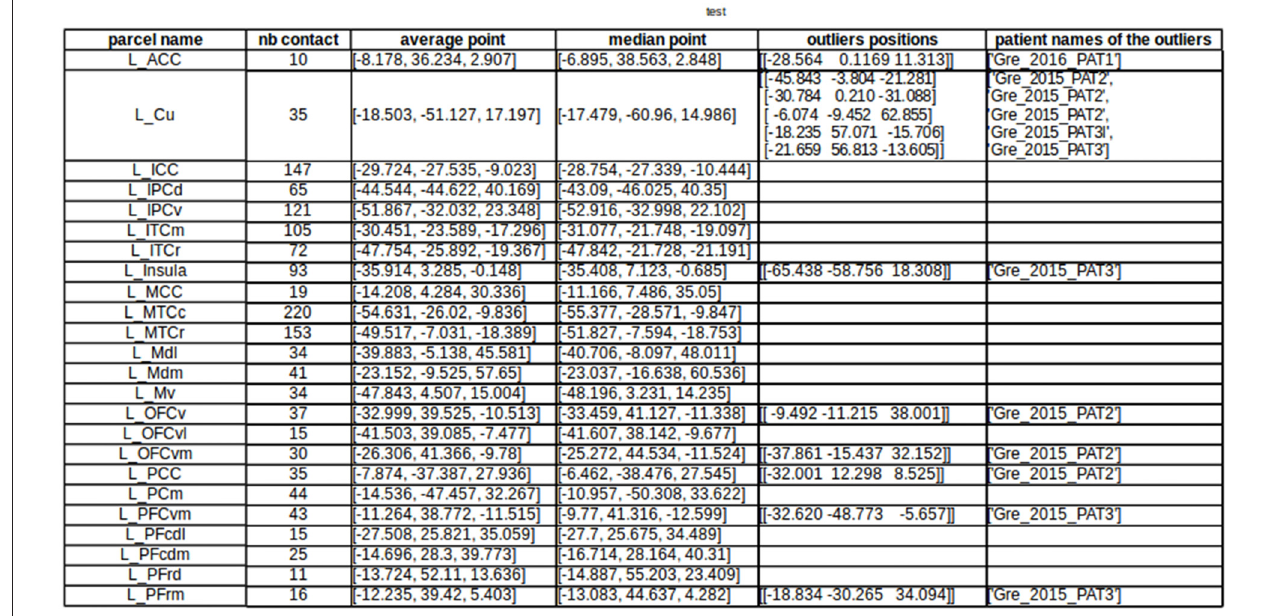
FIGURE 13 | Automatic detection of suspicious parcellation based on the MarsAtlas contact labeling and contact MNI position. This allows quick identification of patients whose atlas labeling failed, by checking the distance between the labeled contacts and the expected location of the region in the MNI